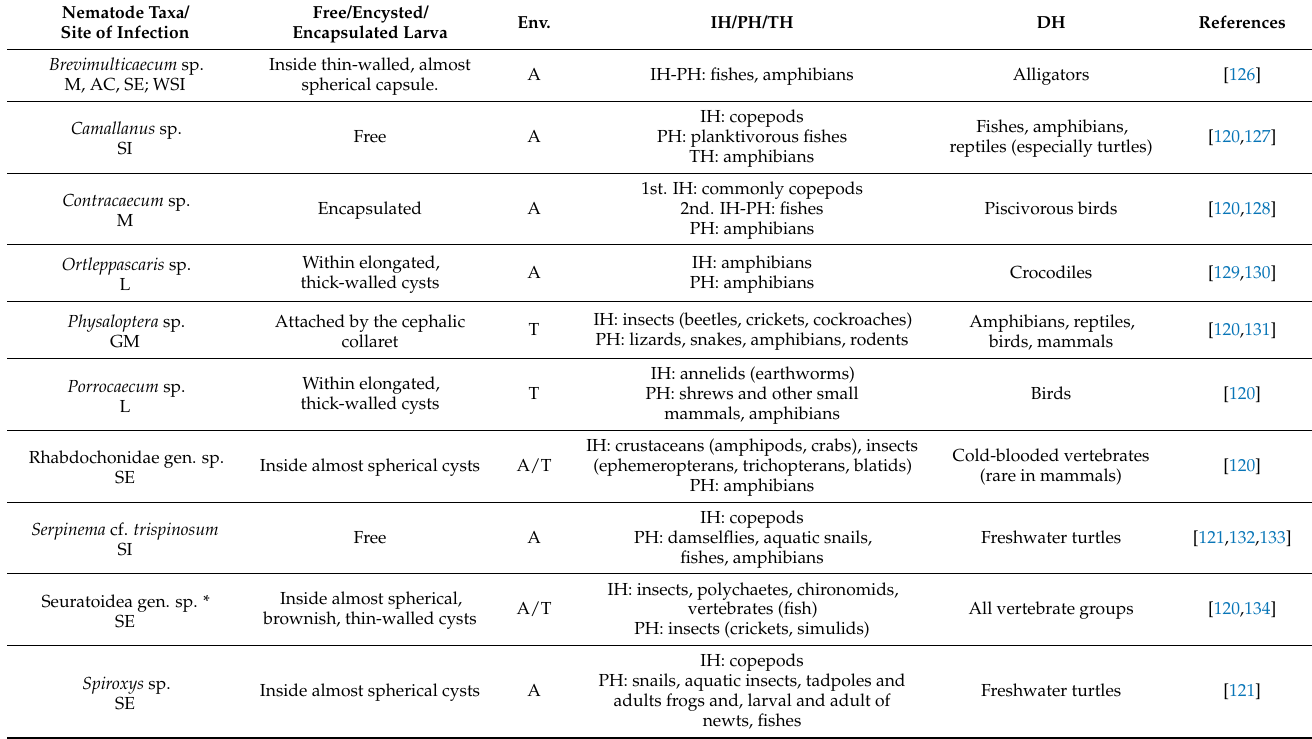
Table 2. Summary of heteroxenous life cycles of nematode parasites from amphibians in Dry and Humid Chaco. Nematode taxa (in alphabetical order), site of infection, free, encysted or encapsulated larva, environment (Env., A: aquatic; T: terrestrial) and type of hosts in the life cycle (DH: definitive hosts; IH: intermediate hosts; PH: paratenic hosts; TH: transport